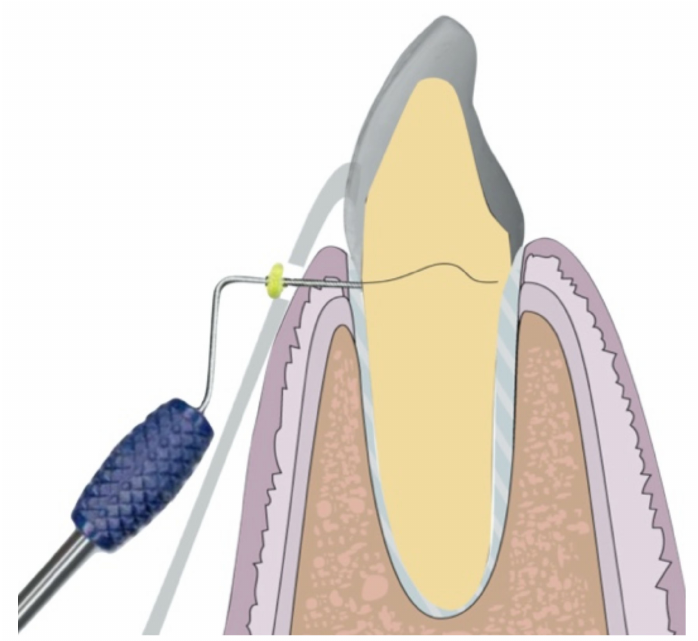
Figure 7. Illustration showing the measurement technique with the Essix-type